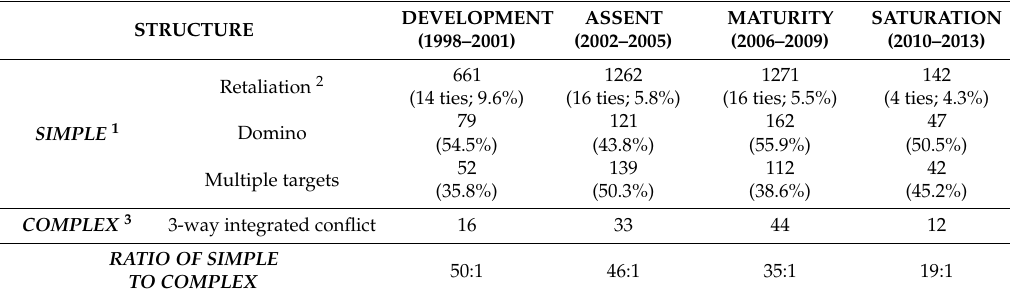
Table 2. Triad Census by Observation Period.